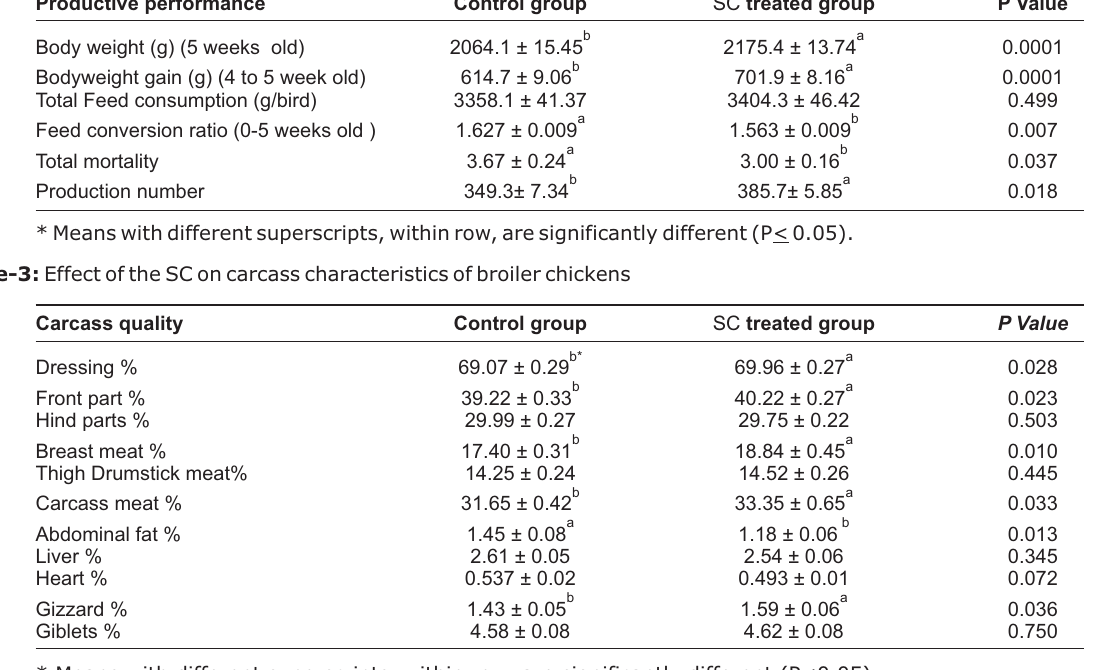
Table-2: Effect of the SC on productive performance and mortality of broiler chickens. Productive performance